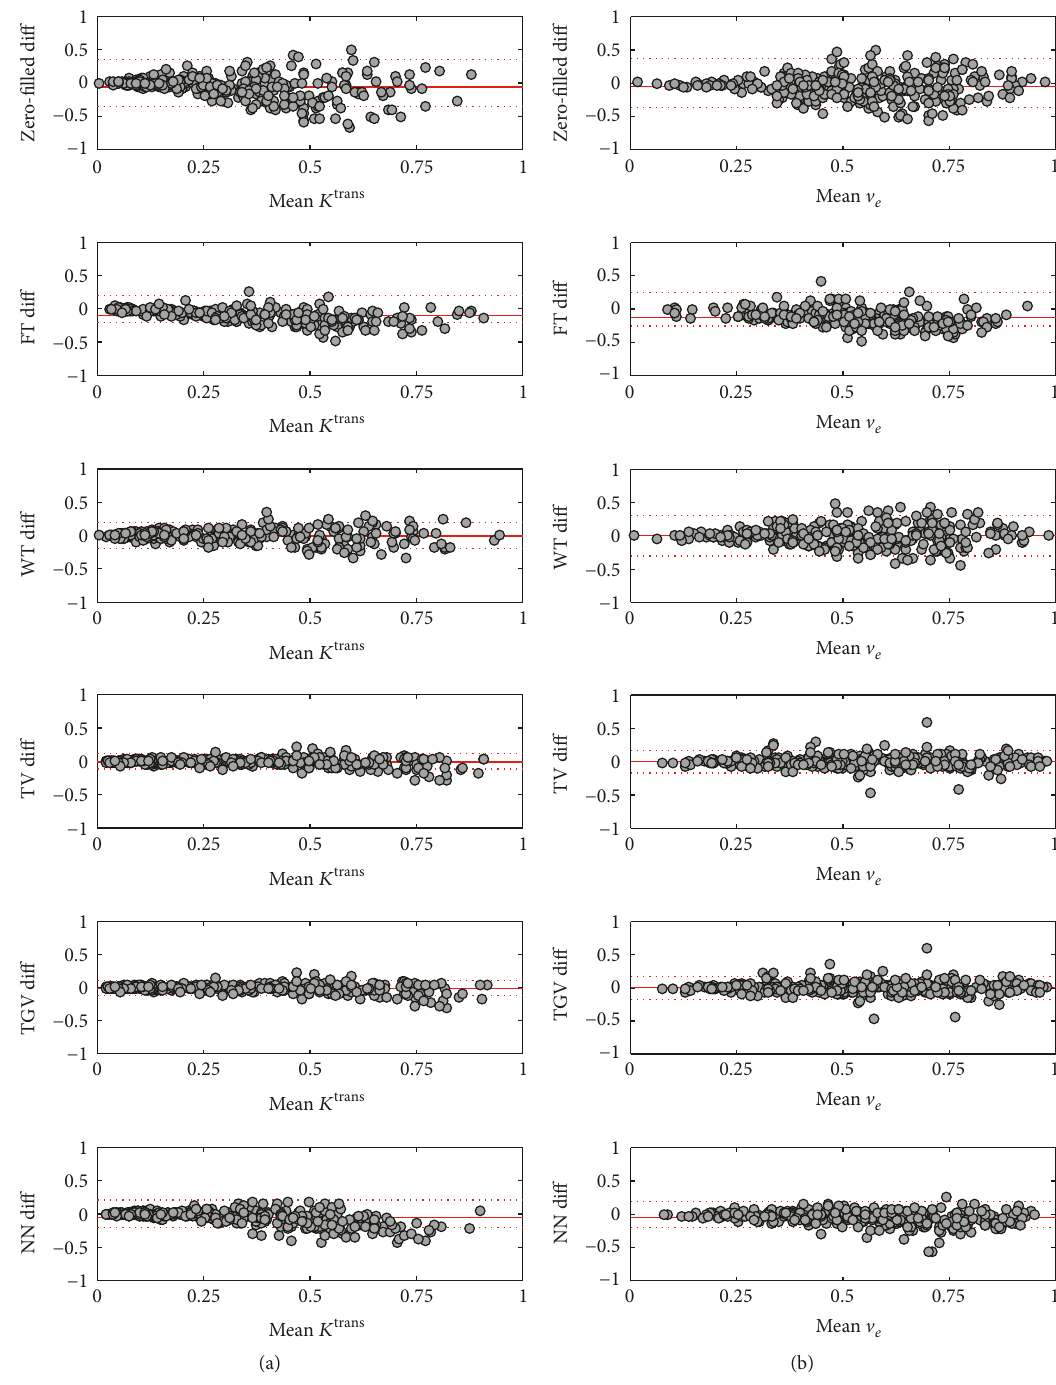
Figure 5: Bland-Altman plots of 𝐾 trans and V 𝑒 of the first mask for all five temporal regularizers. (a) is 𝐾 trans , and (b) is V 𝑒 . Rows from top to bottom correspond to WT, FT, TV, TGV 2 𝛼 , and NN, respectively. TV and TGV appear to produce the most accurate and least biased parameters. FT was the most biased, and WT was the least accurate. NN was relatively inaccurate but had only a small